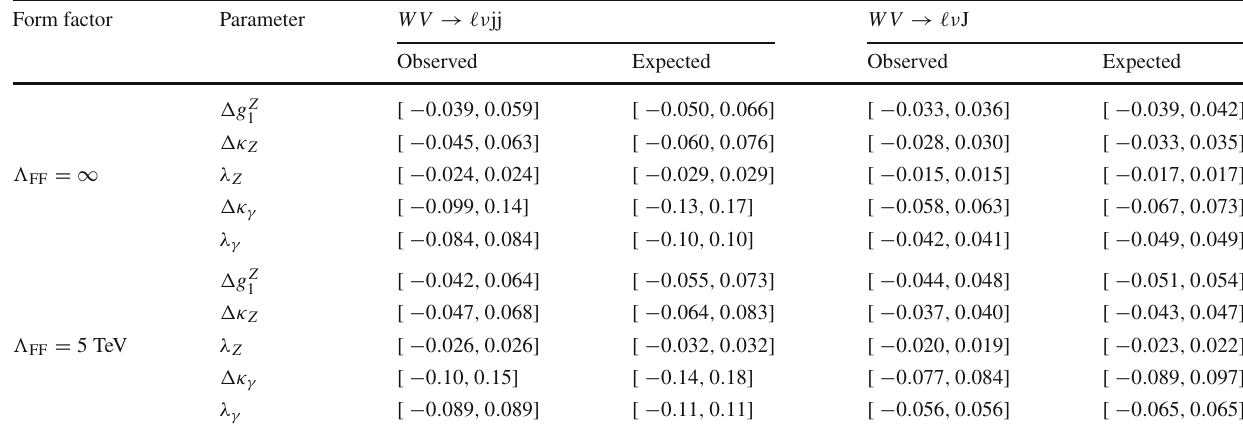
c WWW /(cid:17) 2 = 8 TeV − 2 . The hatched bands indicate the systematic uncertainty in the SM prediction. The histograms are displayed with the binning that is used for the computation of the confidence intervals for the aTGC and EFT parameters. The last bin includes overflow nels, and are calculated both for (cid:17) FF = 5 TeV and (cid:17) FF = ∞ (i.e. no form factor). The confidence intervals for each parameter are calculated while fixing the other parameters to